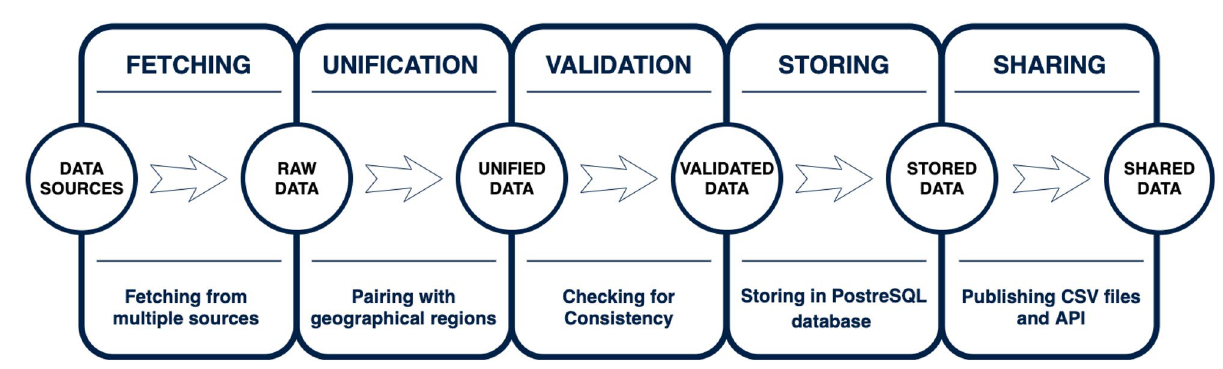
Figure 3. System architecture for OxCOVID19